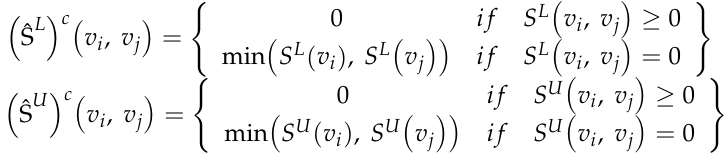
Figure 11. Complement of Figure 10 based on Definition 9.